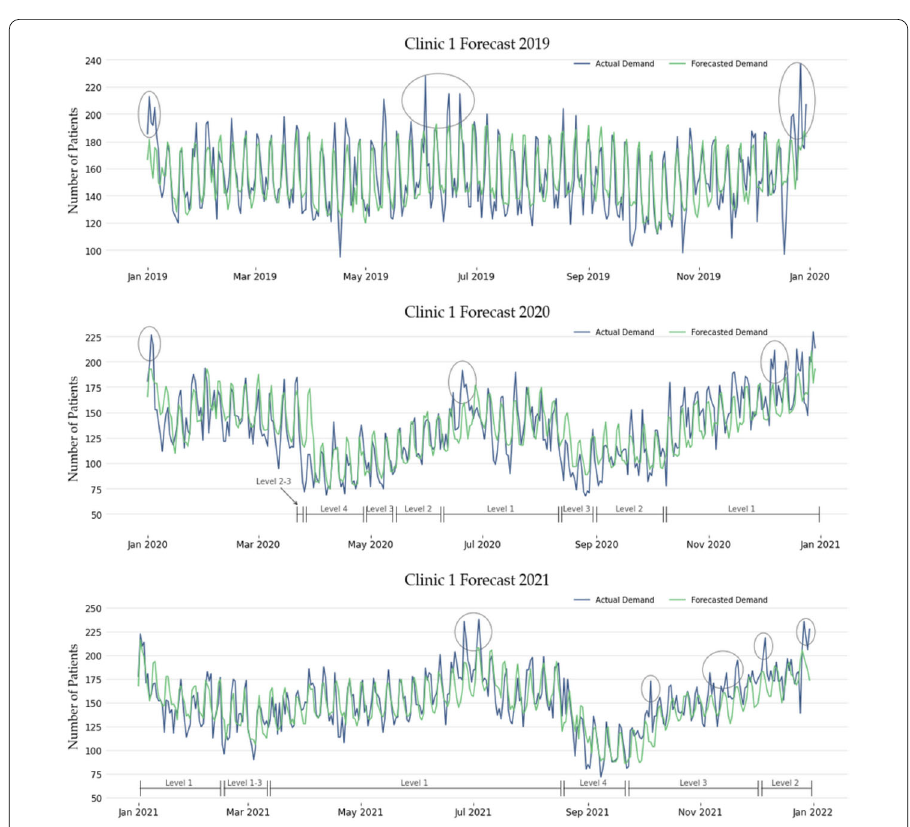
Figure 7 Example of forecasts versus observations between 2019 and 2021 with the corresponding pandemic Alert Levels on the x-axis highlighted